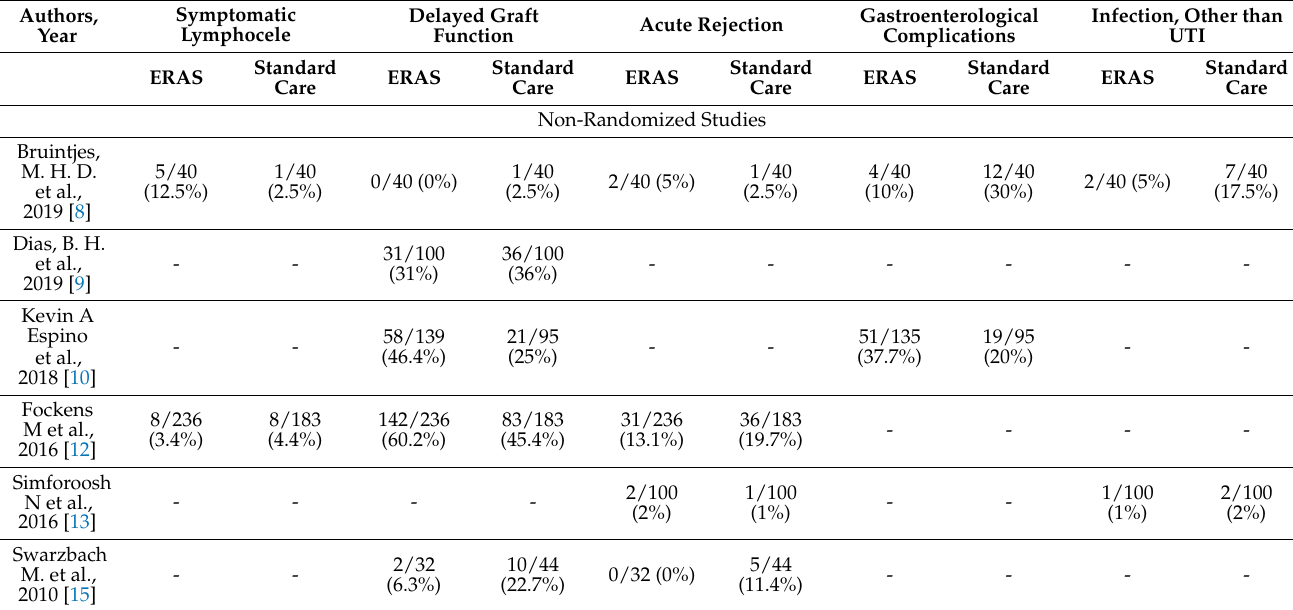
Table 8. Recipients’ non-urological complications